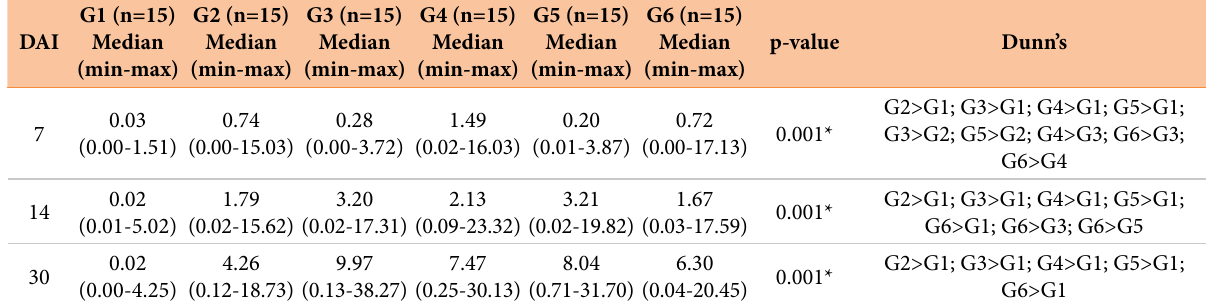
Table 6 - Quantitative analysis of collagen fibers in partial thickness burn wounds experimentally induced in Wistar rats treated with calcium and/or sodium alginate hydrogel-based dressings #